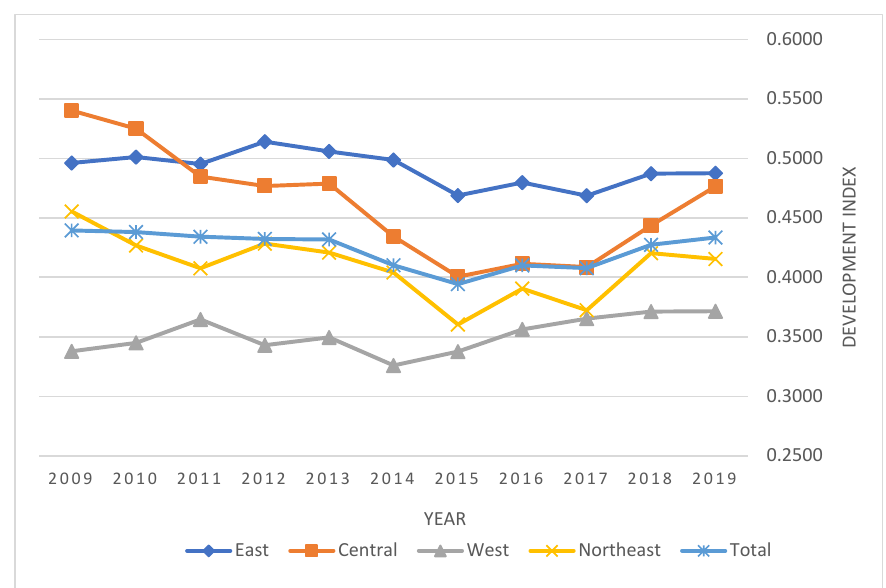
Figure 2. Sub-regional development index of the aging industry.